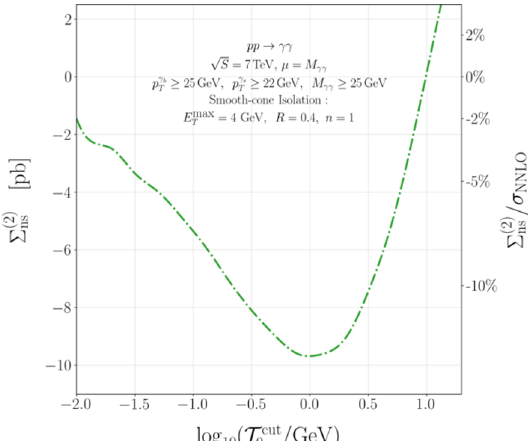
Figure 5 . The neglected O ( α 2 of T cut